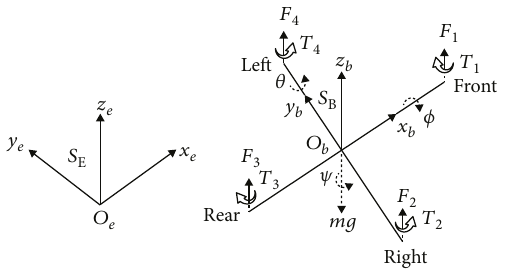
Figure 1: Reference coordinate frames S